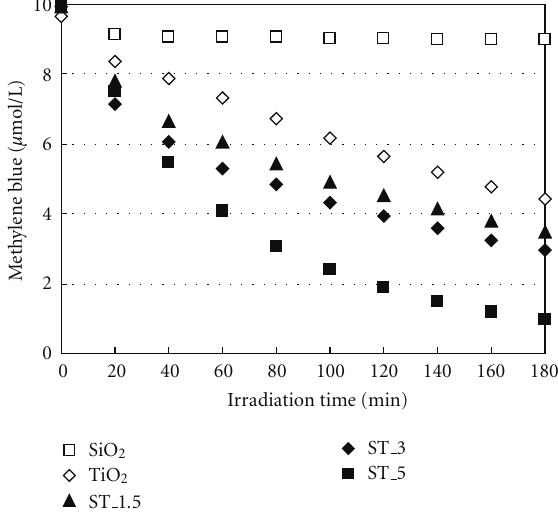
Figure 7: Photocatalytic decomposition of methylene blue over SiO 2 , TiO 2 , and ST serial composite thin